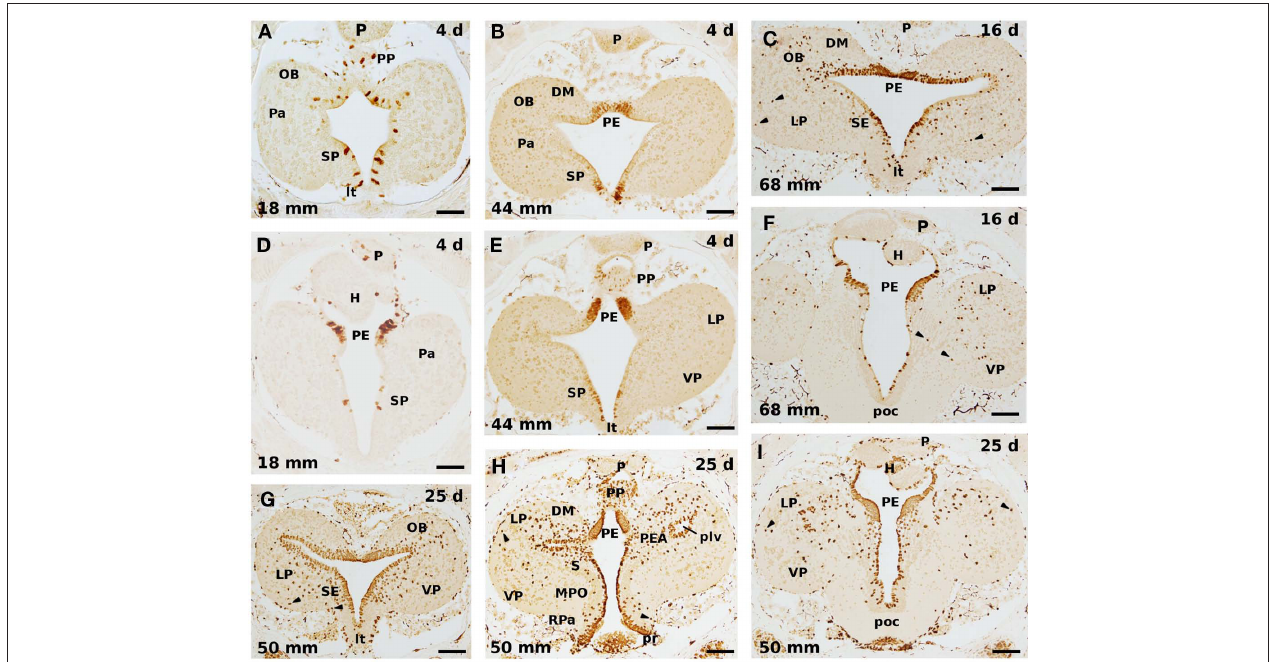
labeling is present in the periventricular portion of the still small prethalamic eminence in all cases. Arrowheads point to laterally displaced labeled